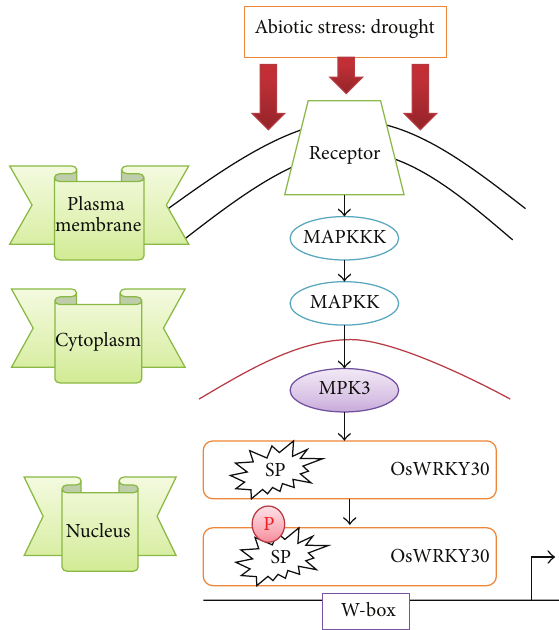
Figure 1: The mitogen-activated protein kinase (MAPK) pathway induces the activity of OsWRKY30 during drought stress. Stress signals are sensed via a transmembrane receptor, which with the help of some unknown molecules and adaptor proteins activates the MPK/MAPK pathway. This leads to the phosphorylation and activation of the MPK3. MPK3 phosphorylates the target Ser residue in the SP motif of OsWRKY30 and activates the same. The activated WRKY protein then undergoes a conformational change which favourably allows it to bind to the W-box of its target gene to induce transcription. The protein product encoded by the target gene probably helps the plant system in combating the drought